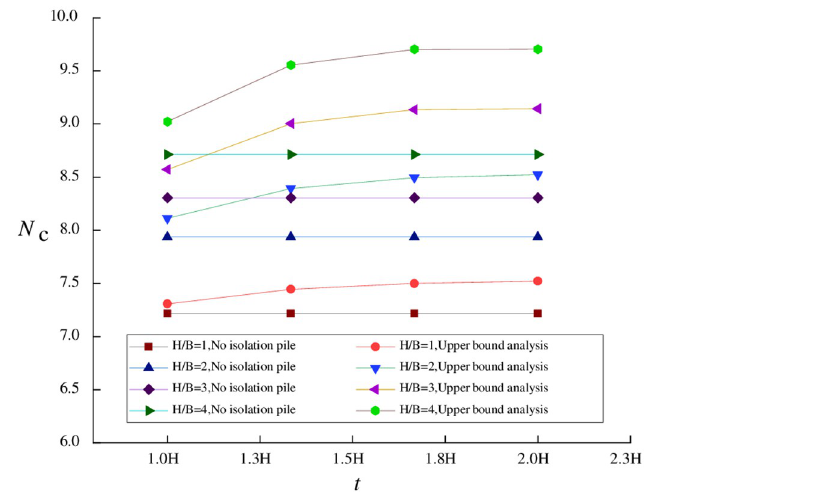
Fig 4. Relationship between stability coefficient and t ( e = 1m).